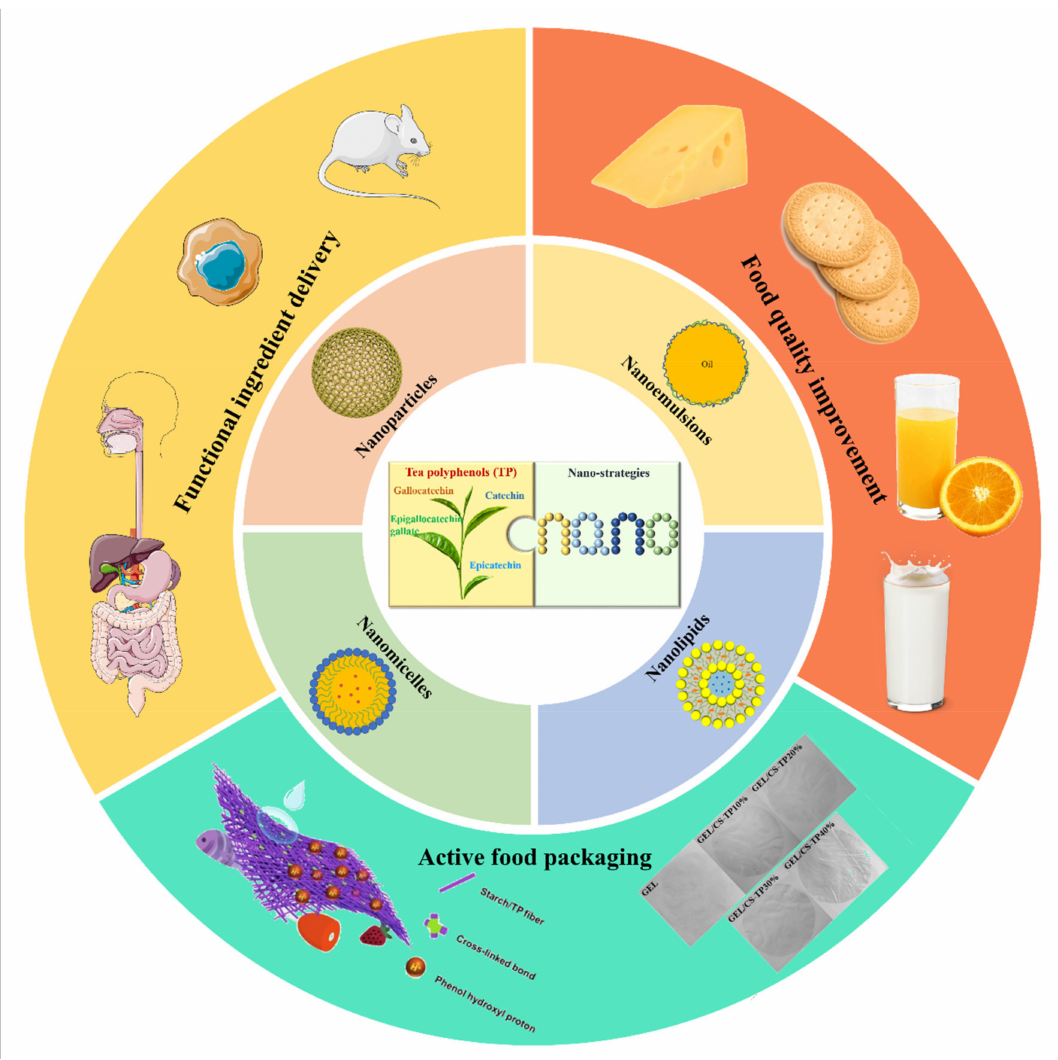
Figure 1. Bioavailability and application prospects of tea polyphenols improved by nano-strategies. (The figures of active food packaging are cited from [36,37], Copyright © 2021, Elsevier; Copyright © 2020,